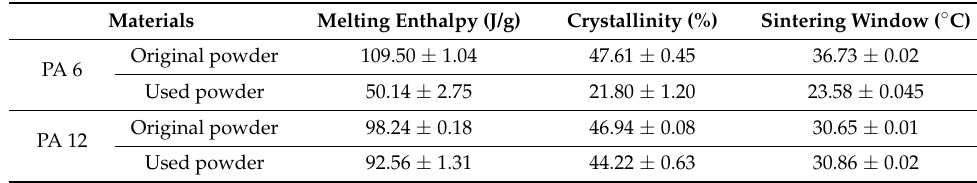
Table 2. Changes of thermal properties of PA 6 and PA 12 after a single print cycle